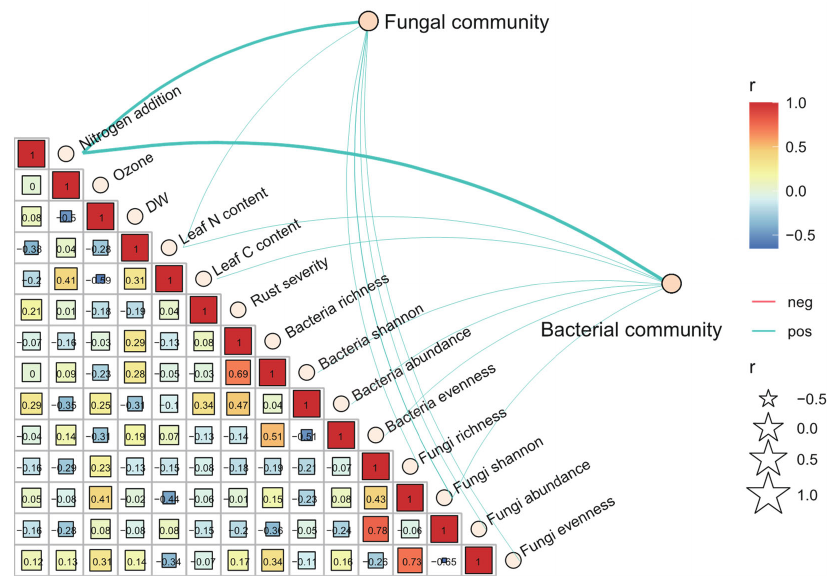
Figure 5. The Mental tests and Spearman’s correlation coefficients between α -diversity indices of Melampsora larici-populina -infected poplar phyllosphere fungal and bacterial communities with nitrogen addition, ozone concentration (Ozone), leaf dry weight (DW), leaf nitrogen and carbon content, and rust severity. Table 1. The effects of polar clone, N addition, elevated O 3 concentration and Melampsora larici- populina ( Mlp ) infection on the phyllosphere bacterial and fungal communities based on PER- MANOVA